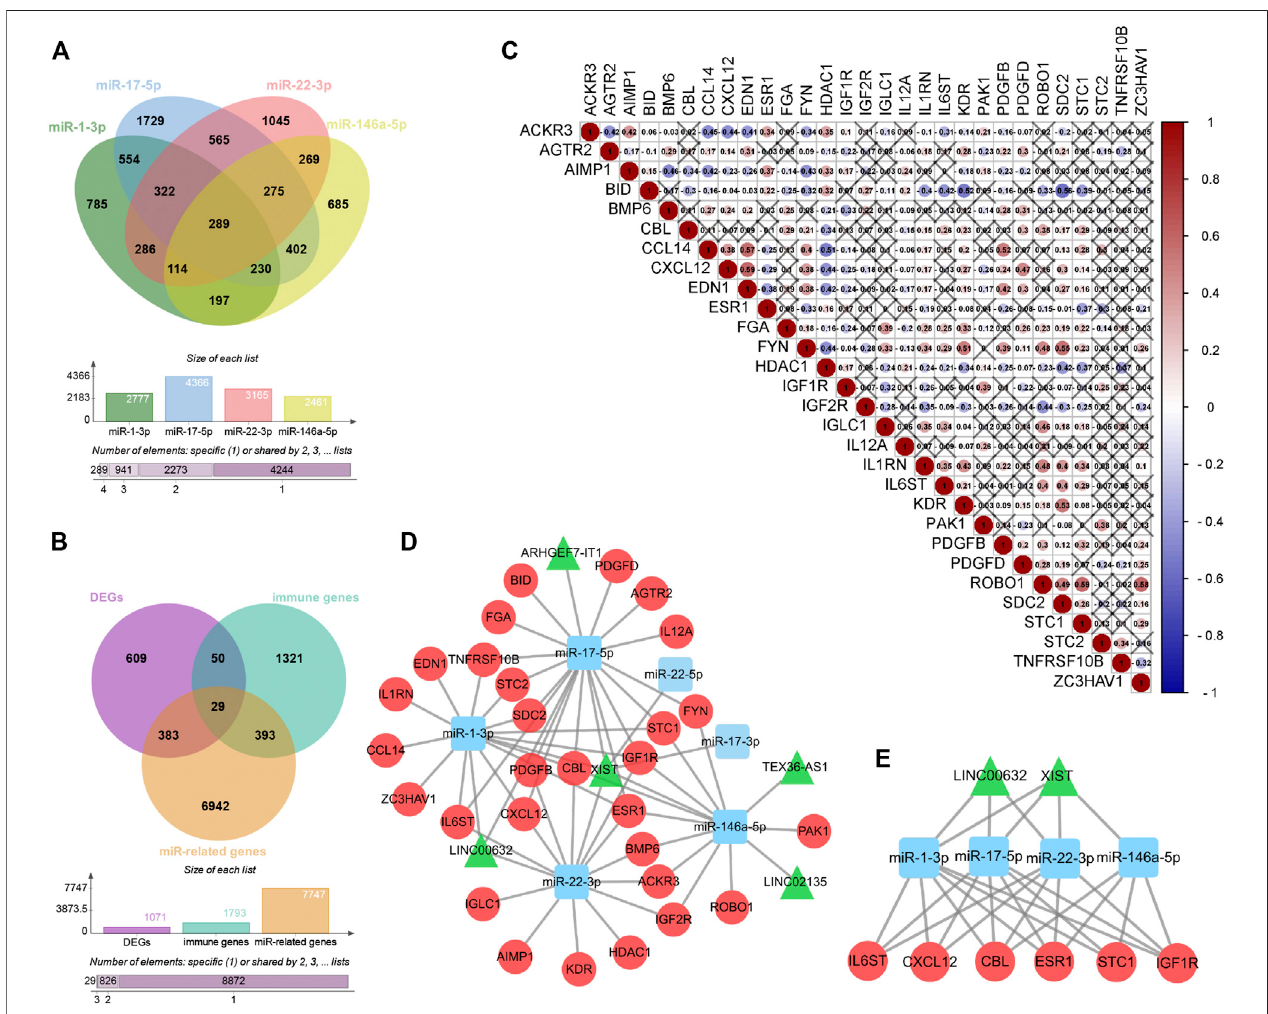
FIGURE 6 | Construction of Sex difference Immune-related ceRNA Networks. (A) Intersection between four kinds of microRNAs. (B) Intersection between DEGs, miR-relatedgenesandimmunegenes. (C) Co-expressionanalysisofimmune-relatedDE-mRNAs. (D) ceRNAnetworkamonglncRNAs,miRNAs,andmRNAs,Circular, mRNAs; triangle, lncRNAs; square, miRNAs. (E) Central module from the ceRNA network.